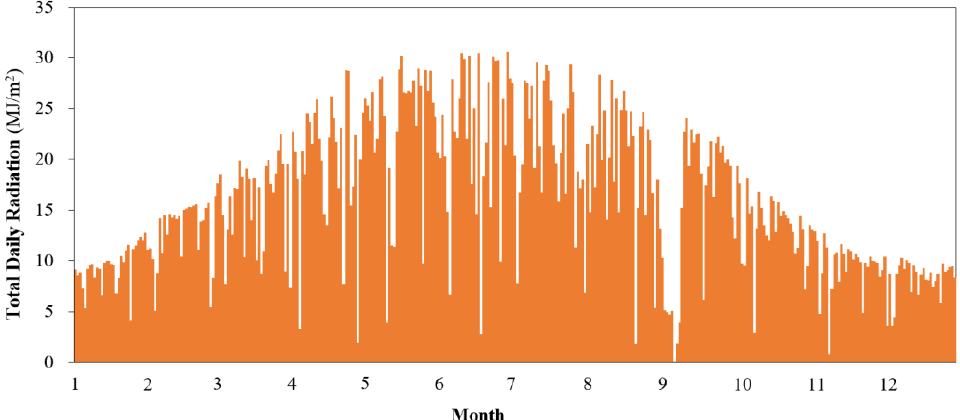
Figure 2. The monthly variation of solar irradiation in Baotou of Inner Mongolia [22].